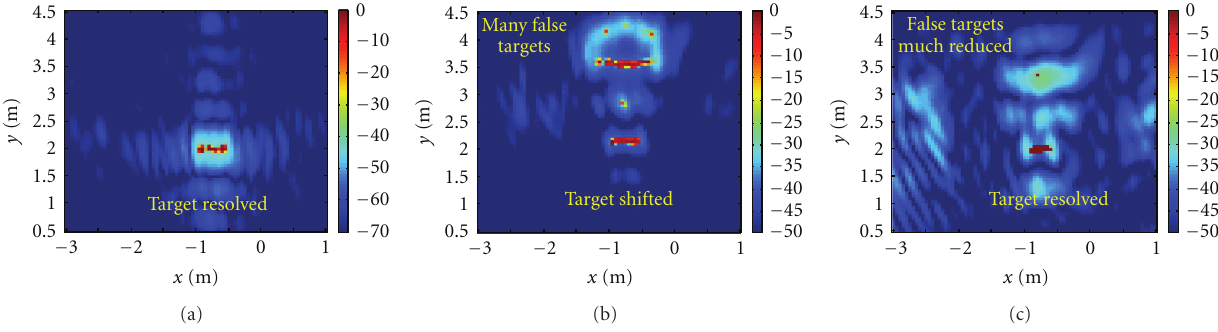
Figure 7: Sparse images ( P = 0 . 8, λ = 9,20 iterations) of a metallic plate extending from x = − 1 to − 0.5 at y = − 2 for the configuration in Figure 2 with data collected over the band 1.7–2.0 GHz: (a) image in free space, (b) image in presence of the cinderblock wall using the free space Green’s function, (c) image in presence of the cinderblock wall using the periodic layer Green’s function.